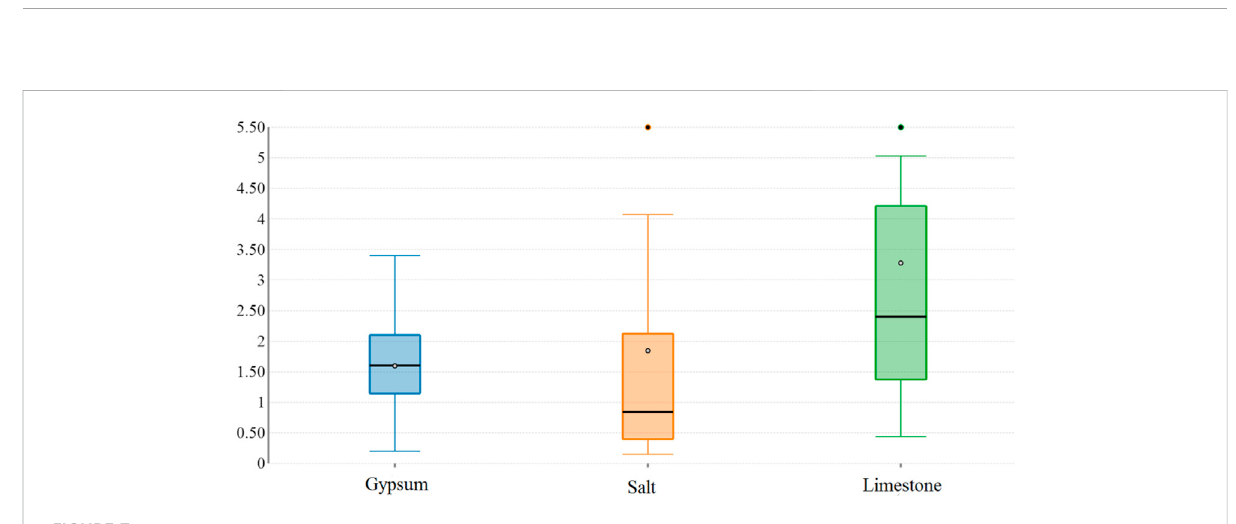
FIGURE 7 Displaying box and whisker plot of the Rn